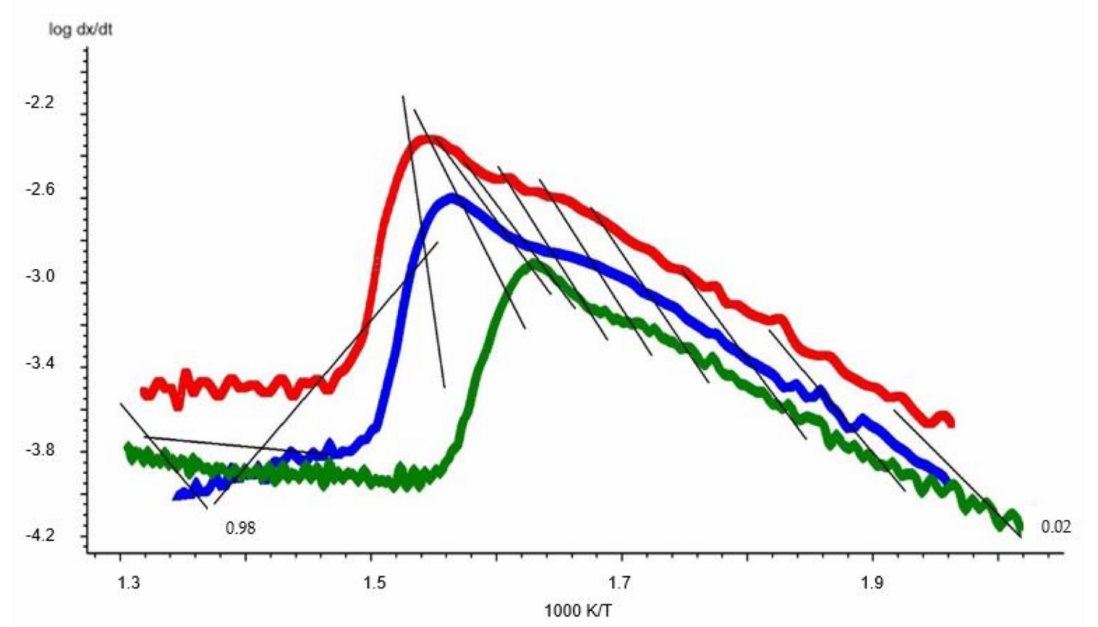
Figure A3. Plot of logarithm dx/dt as a function of reciprocal of temperature by Friedman method for pine wood. Red line represents 20 K/min, blue line is 10 K/min and green line is 5 K/min.